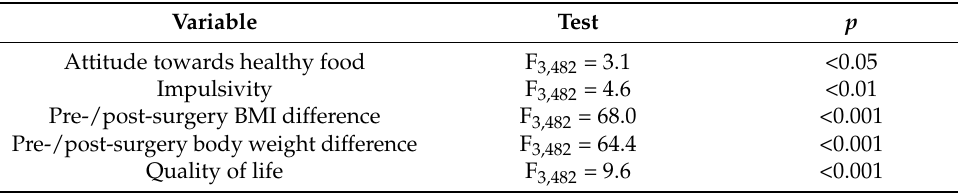
Table 4. Analyses of variances with time since bariatric surgery as a group variable.